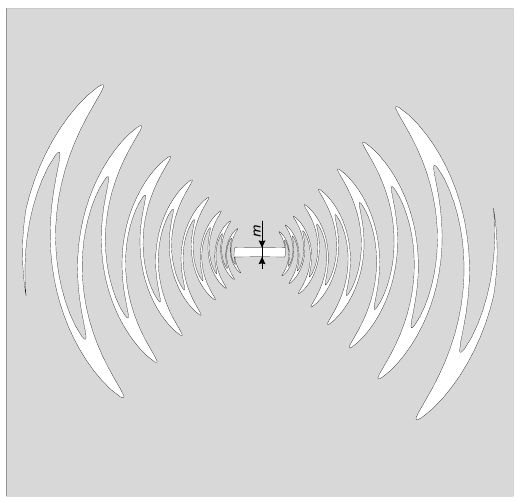
Figure 2. The two arms of the sinuous slot antenna.